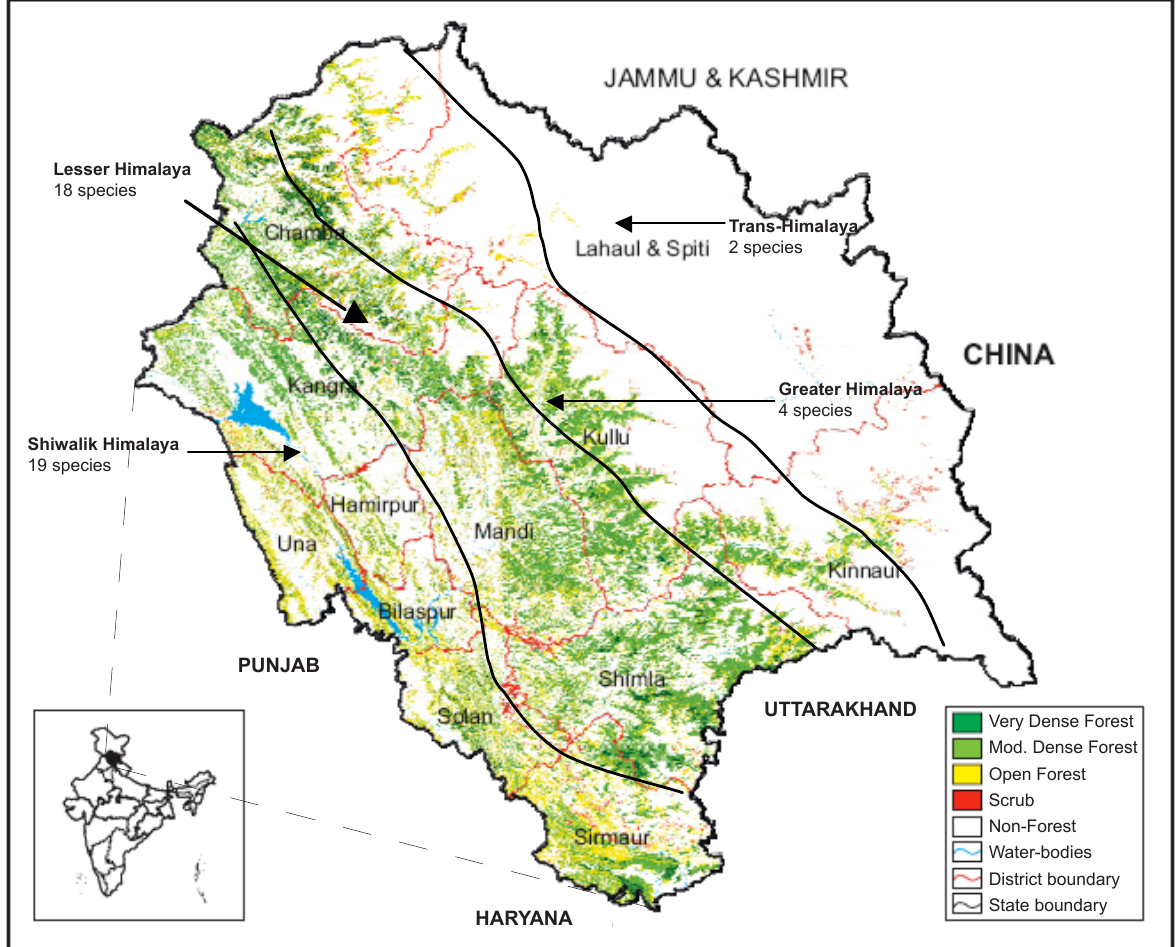
Figure 2. Species diversity of Chiroptera in the four physiographic zones of Himachal Pradesh (based on recorded localities). Boundaries of physiographic zones depicted in the map are provisional. (Vegetation cover map of Himachal Pradesh: